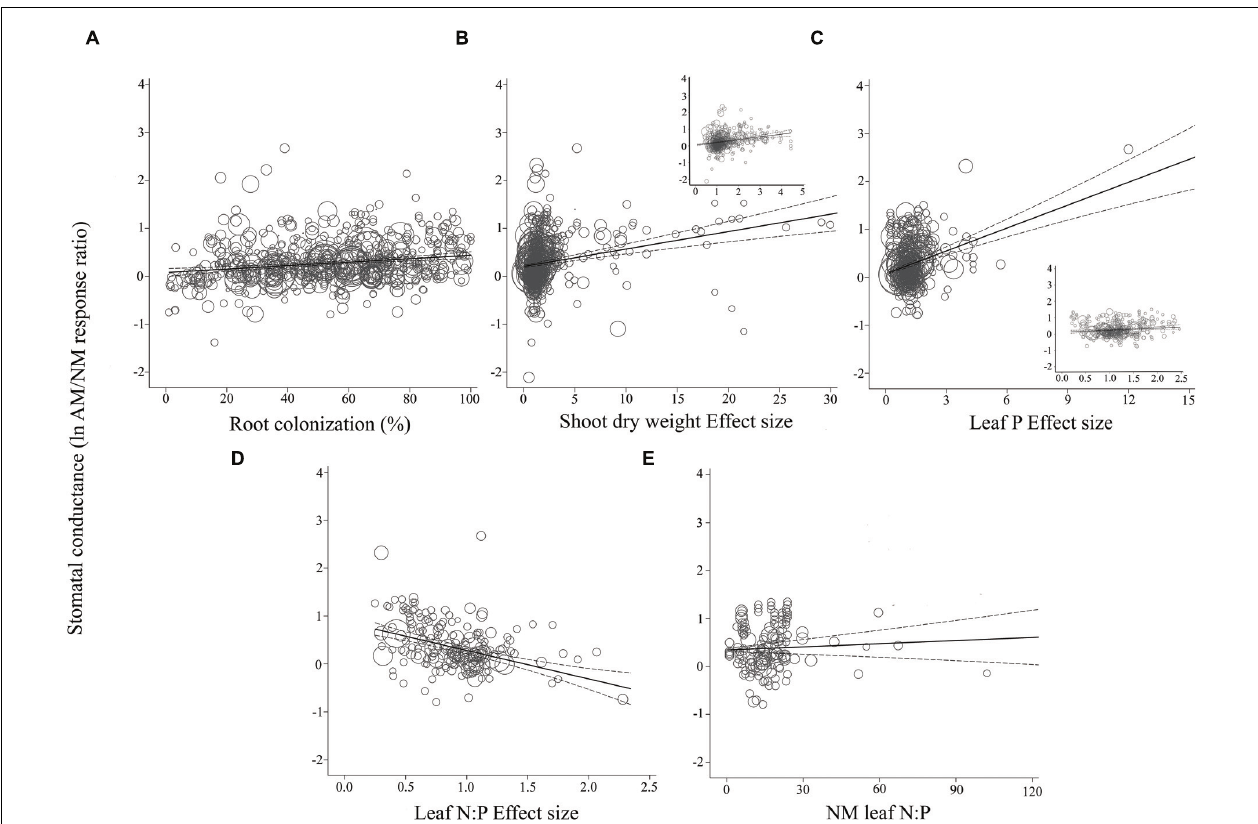
FIGURE 4 | Regression plots of the size of the AM-induced change in stomatal conductance (ln R g s ) as a function of (A) percent root colonization; (B) AM/NM shoot DW effect size; (C) AM/NM leaf P effect size; (D) AM/NM leaf N:P effect size; (E) leaf N:P of NM plants. Darker center line is the model prediction; lighter lines are 95% confidence intervals. Each symbol represents one study, with symbol size indicating its weighting. Insets in (B) and (C) are expanded views of the ranges containing the majority of